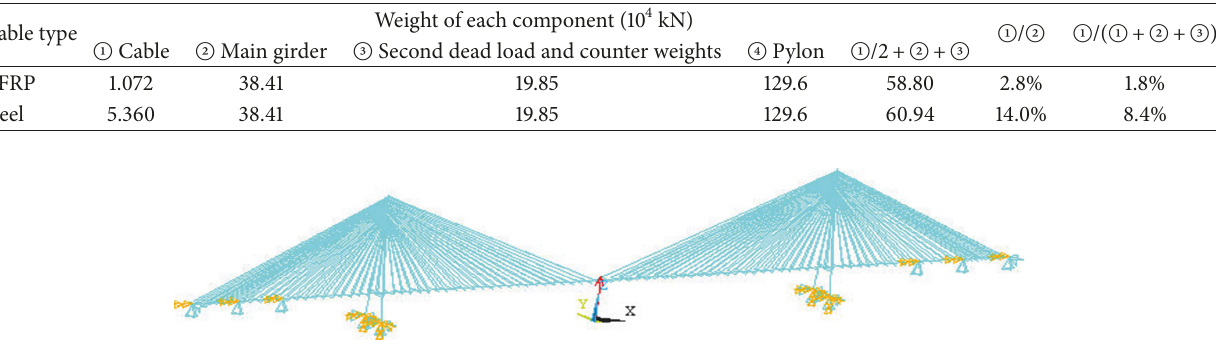
Table 2: Material dosages for CFRP and steel cable-stayed bridges.